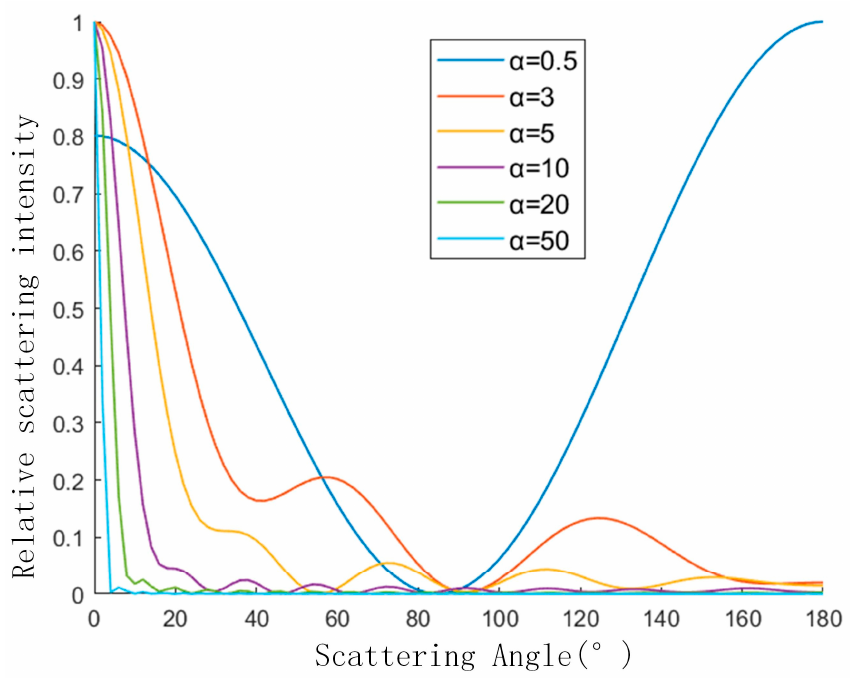
Figure 6. The relationship between scattering angle and scattering light intensity of different sizes copper particles.